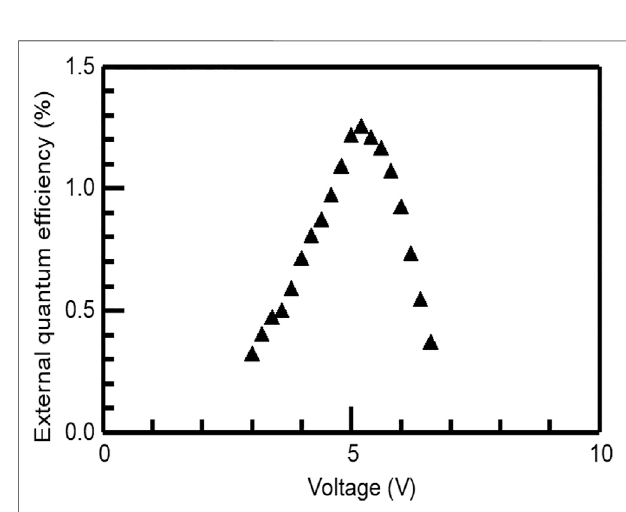
FIGURE 10 | EQE – voltage curve of MA 0.6 FA 0.4 PbI 2.8 Br 0.2 perovskite solar cells.